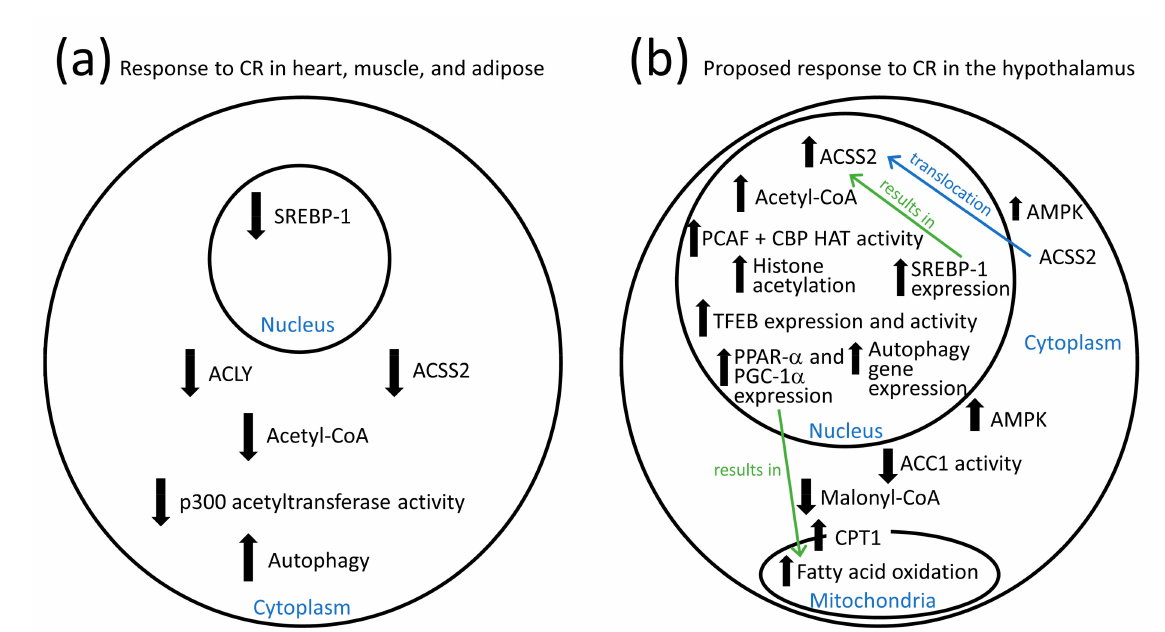
Figure 2. Acetyl-CoA may play different roles in the anti-aging effects of CR in different tissues. ( a ) CR results in decreased cytoplasmic acetyl-CoA levels in heart, skeletal muscle, and adipose tissue to stimulate autophagy to delay aging. ( b ) It is proposed that CR increases histone acetylation on specific promoters in some hypothalamic glial cells by activating AMP kinase (AMPK) that phosphorylates ACSS2 resulting in its nuclear translocation. ACSS2 associates with TFEB on promoters producing acetyl-CoA for PCAF and CBP-mediated histone acetylation and expression of autophagy genes. It is also proposed that the increased histone acetylation leads to increased PPAR- α expression and a shift to fatty acid oxidation. Abbreviations: SREBP-1, Sterol regulatory binding protein-1; ACLY, ATP-citrate lyase; ACSS2,